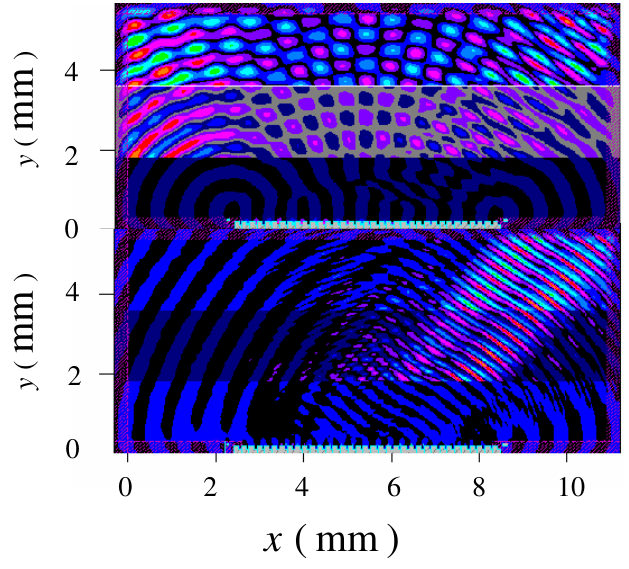
FIG. 3. (Color) x - y contour maps of B (Dartmouth). The latter shows clear evidence of coherent SP radiation at twice the evanescent frequency, which may then be recognized in the former, amidst the radiation at the evanescent frequency emitted at the grating ends.